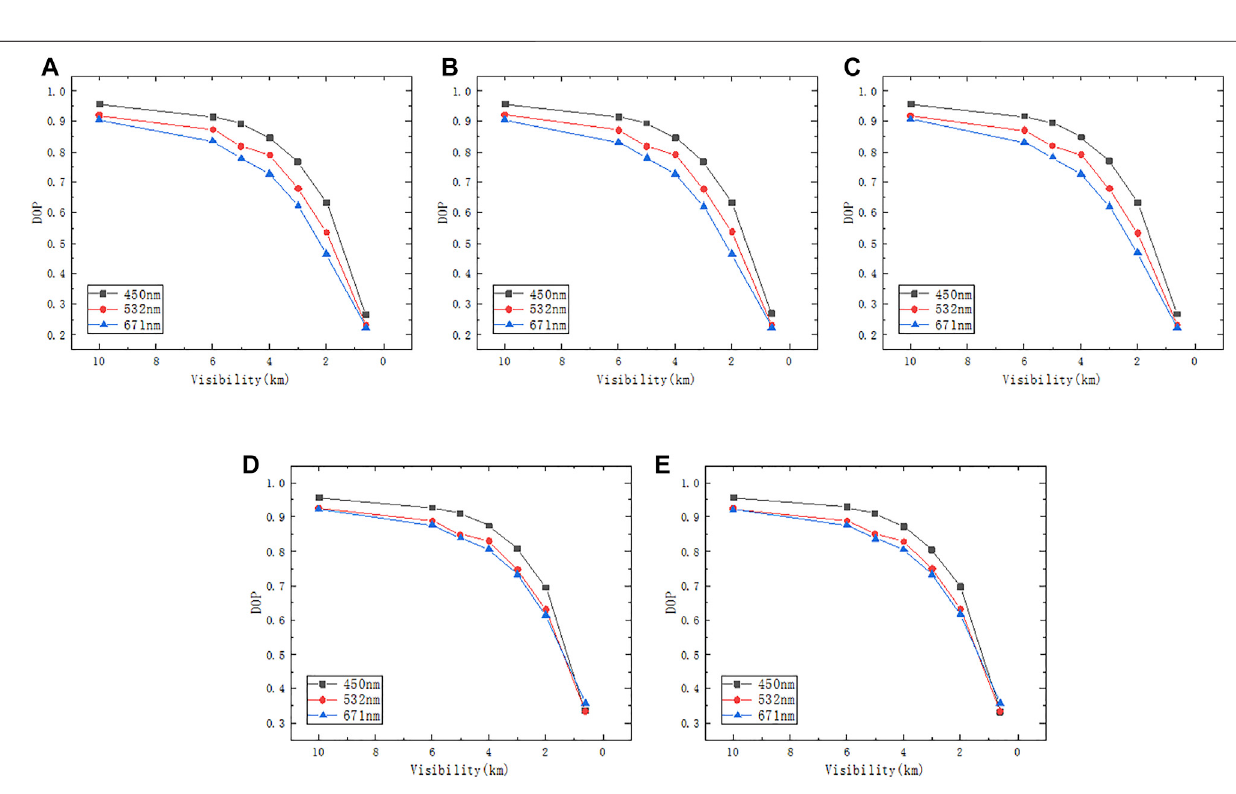
Frontiers in Physics |